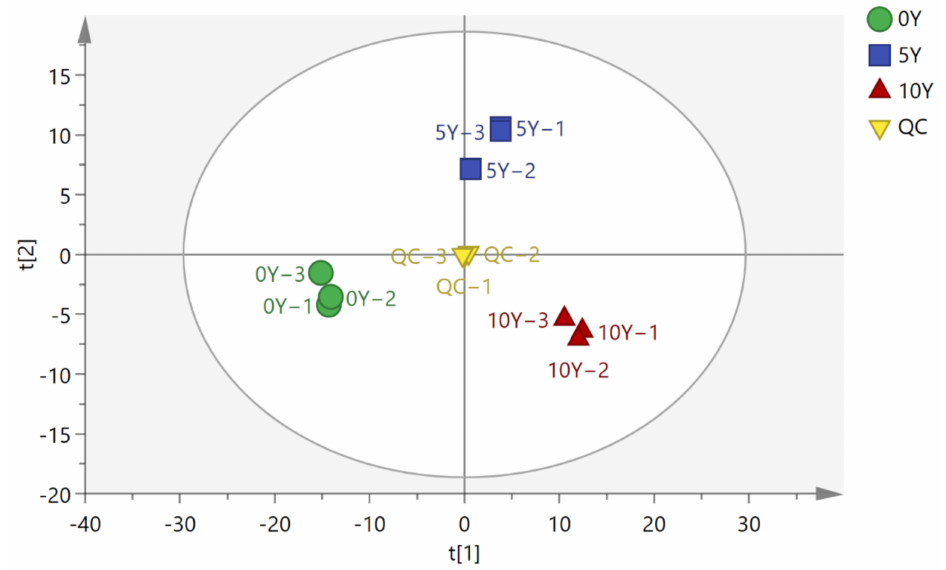
Figure 1. The scatter plots of the PCA model for the 0Y, 5Y, and 10Y fermented kohlrabi samples rep- resenting 0-year, 5-year and 10-year ultra-long-term industrially fermented kohlrabies, respectively.